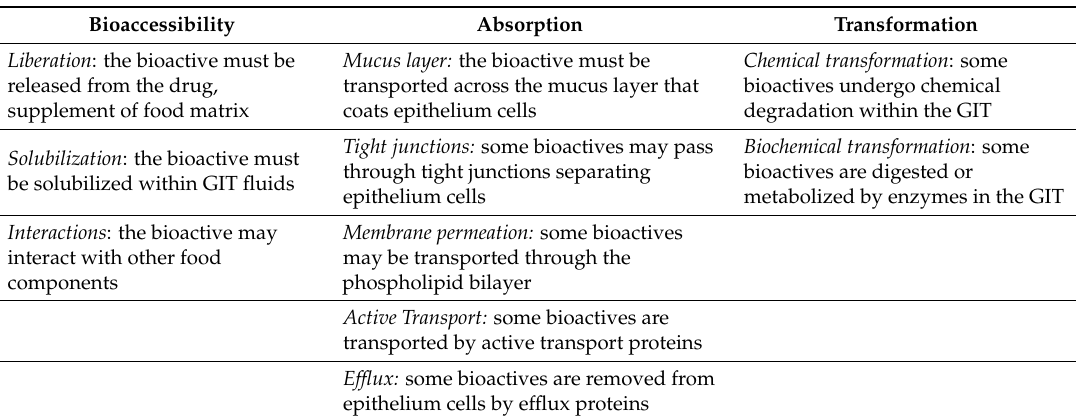
Table 2. Examples of potential excipient foods to be co-ingested with natural food products to enhance the oral bioavailability of bioactive